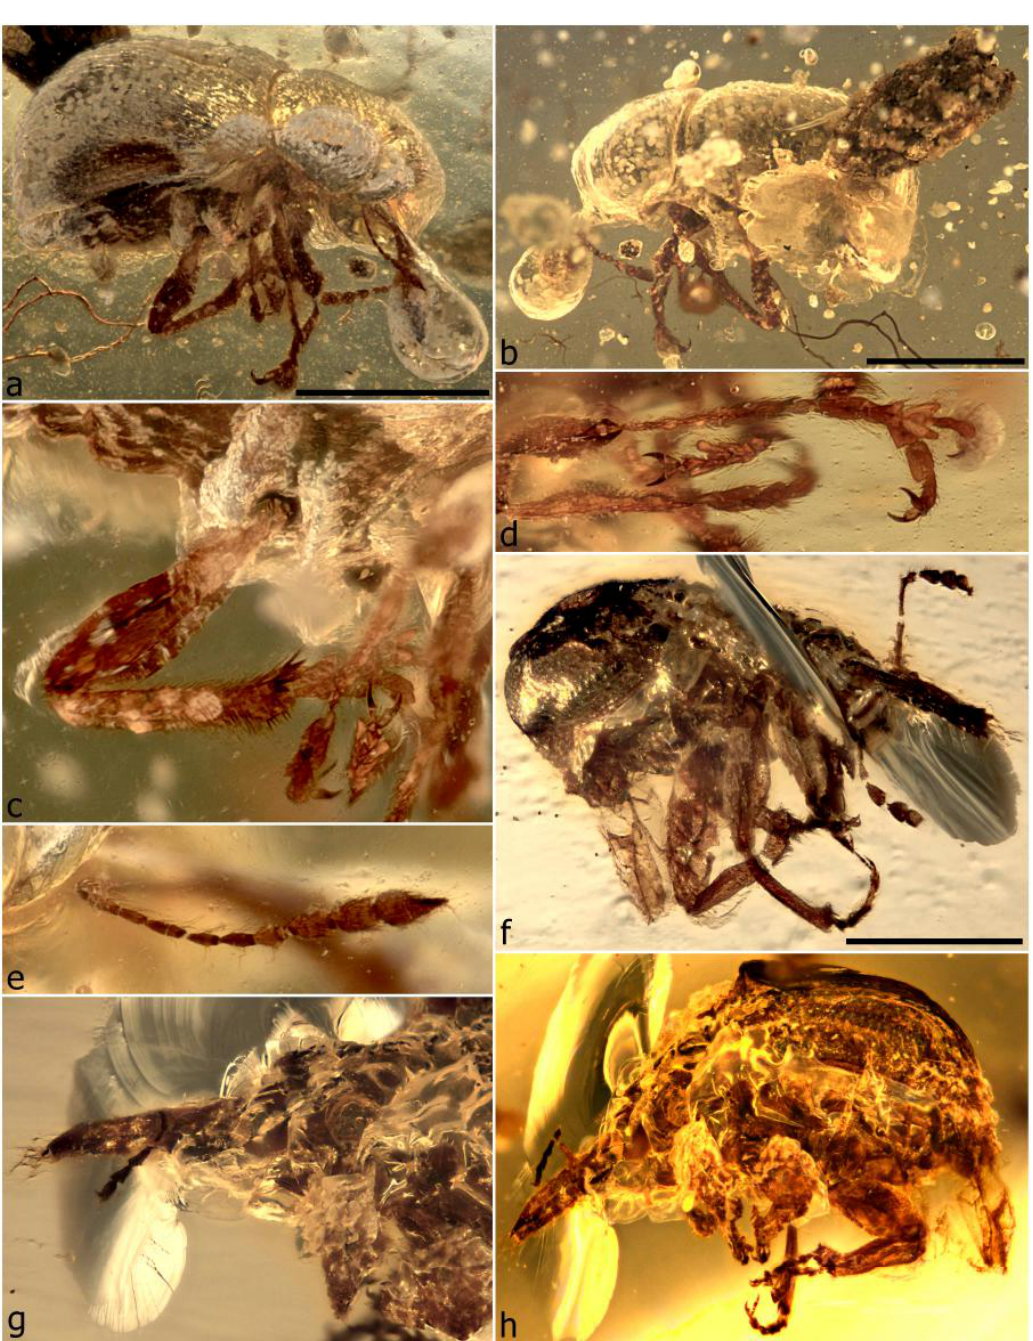
Figure 54. Gnomus spinipes sp. n., holotype ( a – e ) and Gnomus sp. ( f – h ). Habitus, left lateral ( a ); habitus, right lateral ( b ); right hindleg ( c ); protibia and tarsi ( d ); right antenna ( e ). Habitus, right caudolateral ( f ); head and rostrum, left lateral ( g ); habitus, left lateral ( h ). Scale bars: 1.0 mm (a,b,f).